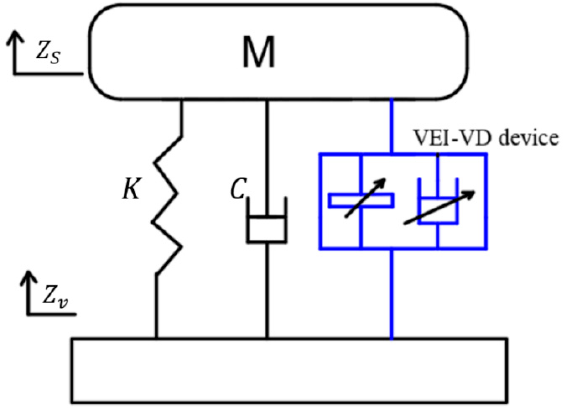
Figure 1. The model of VEI-VD seat suspension.